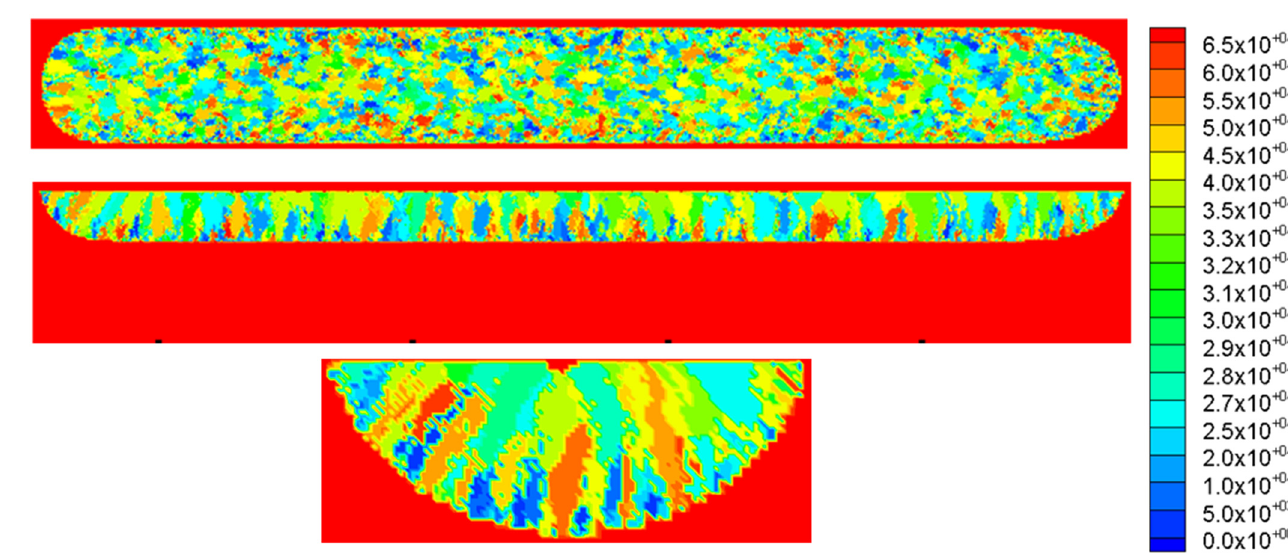
Figure 3. 3D grain structure simulation results: (middle XY, XK, and YK planes).